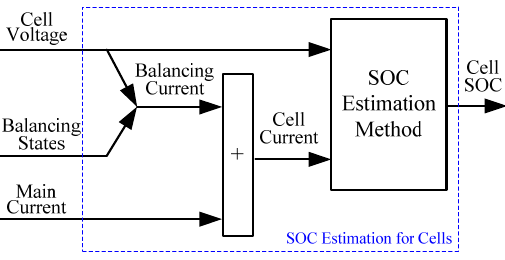
Figure 6. SOC estimation for the cells in the battery